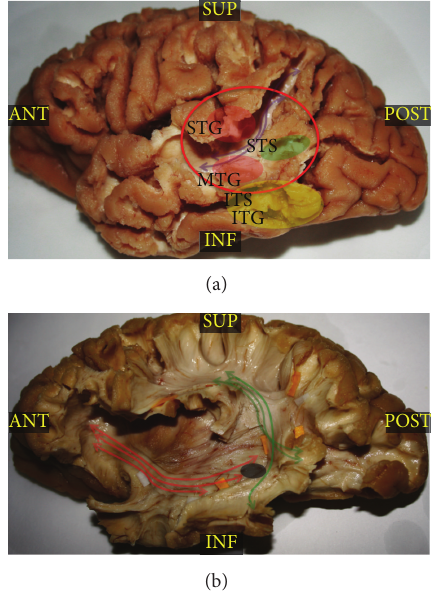
Figure 1: (a) This left hemisphere dissected with Klingler’s tech- nique is focused on the posterior temporal lobe after removal of the gray matter of the middle and posterior thirds of the superior and inferior temporal sulci (resp., STS and ITS) and of the inferior parietal lobule. The purple arrows show the direction of the indirectposteriorportionofthesuperiorlongitudinalfascicle(SLF), connecting the inferior parietal lobule (angular and supramarginal gyri) to the Wernicke’s territories (posterior thirds of superior and middle temporal gyri and superior temporal sulcus, BA 22), which are evidenced by the red circle. The red circles at the level of the junctionbetweentheposteriorandmiddlethirdsofthesuperiorand middle temporal gyri (resp., STG and MTG) represent the eloquent sites identified by means of cortical DES during denomination task. The yellow circle identifies the inferior temporal gyrus (ITG) language areas shown by fMRI and confirmed by means of cortical DES. Finally, the green circle shows the cortical approach to the lesion directly through the posterior third of the STS (BA 22). (b) After removal of the more superficial cortices of the STG and MTG, the courses and terminations of the direct component of the SFL, the arcuate fasciculus (AF), are demonstrated and evidenced by green arrows. Red arrows evidence the more ventral fibers of IFOF, crossing the AF just underneath the Wernicke’s territories. The grey circle shows the position of cavernous angiomas (CA) in respect to the deeper bundles. ANT: anterior; INF: inferior; ITG: inferior temporal gyrus; ITS: inferior temporal sulcus; MTG: middle temporal gyrus; POST: posterior; STG: superior temporal gyrus; STS: superior temporal sulcus; SUP: